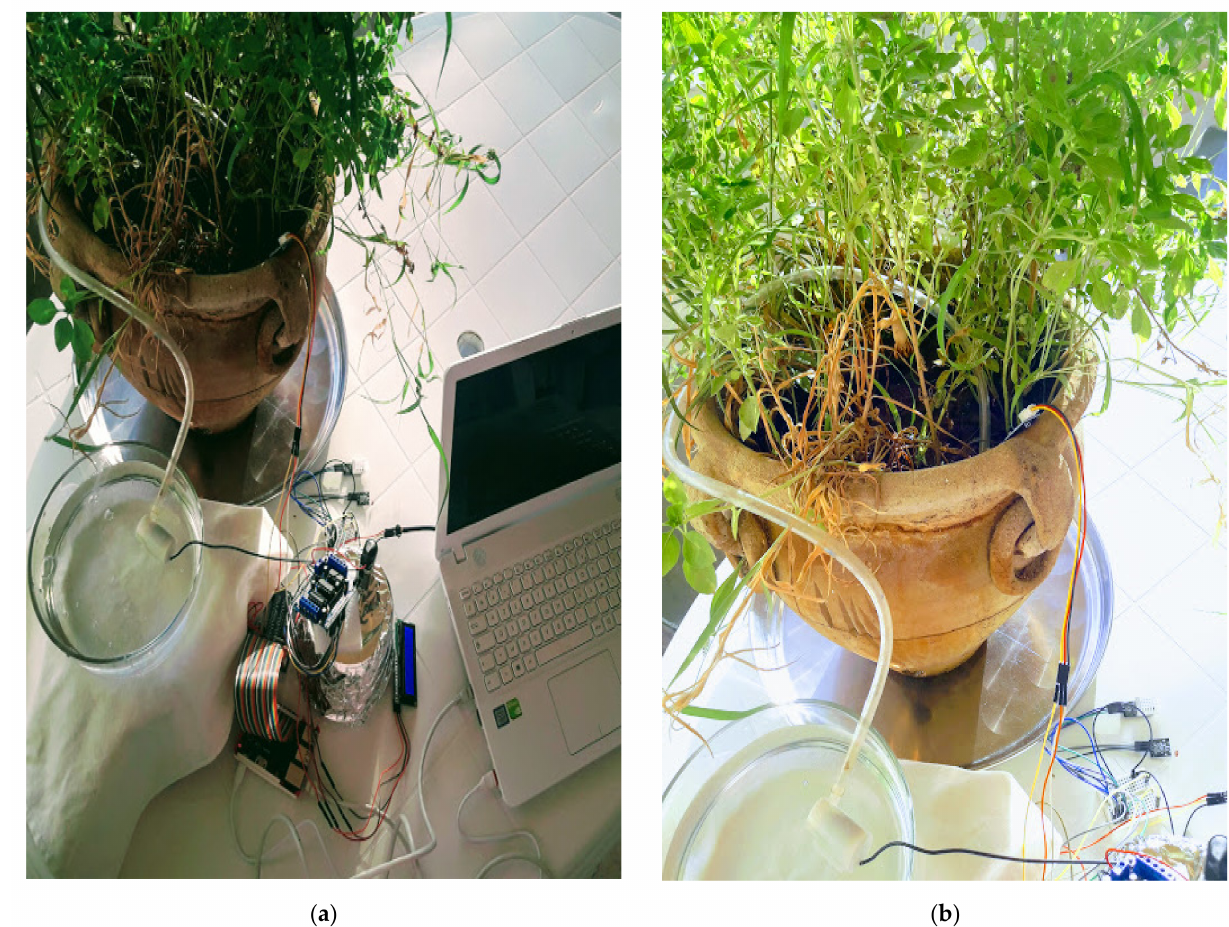
Figure 25. ( a ) Irrigation smart controller prototype realization; ( b ) Sensors and pumping network zoomed